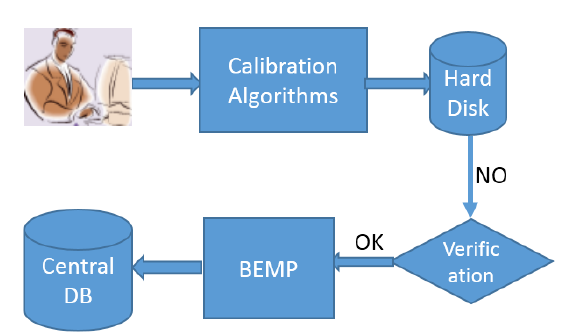
Fig. 2. The processing flow of raw data